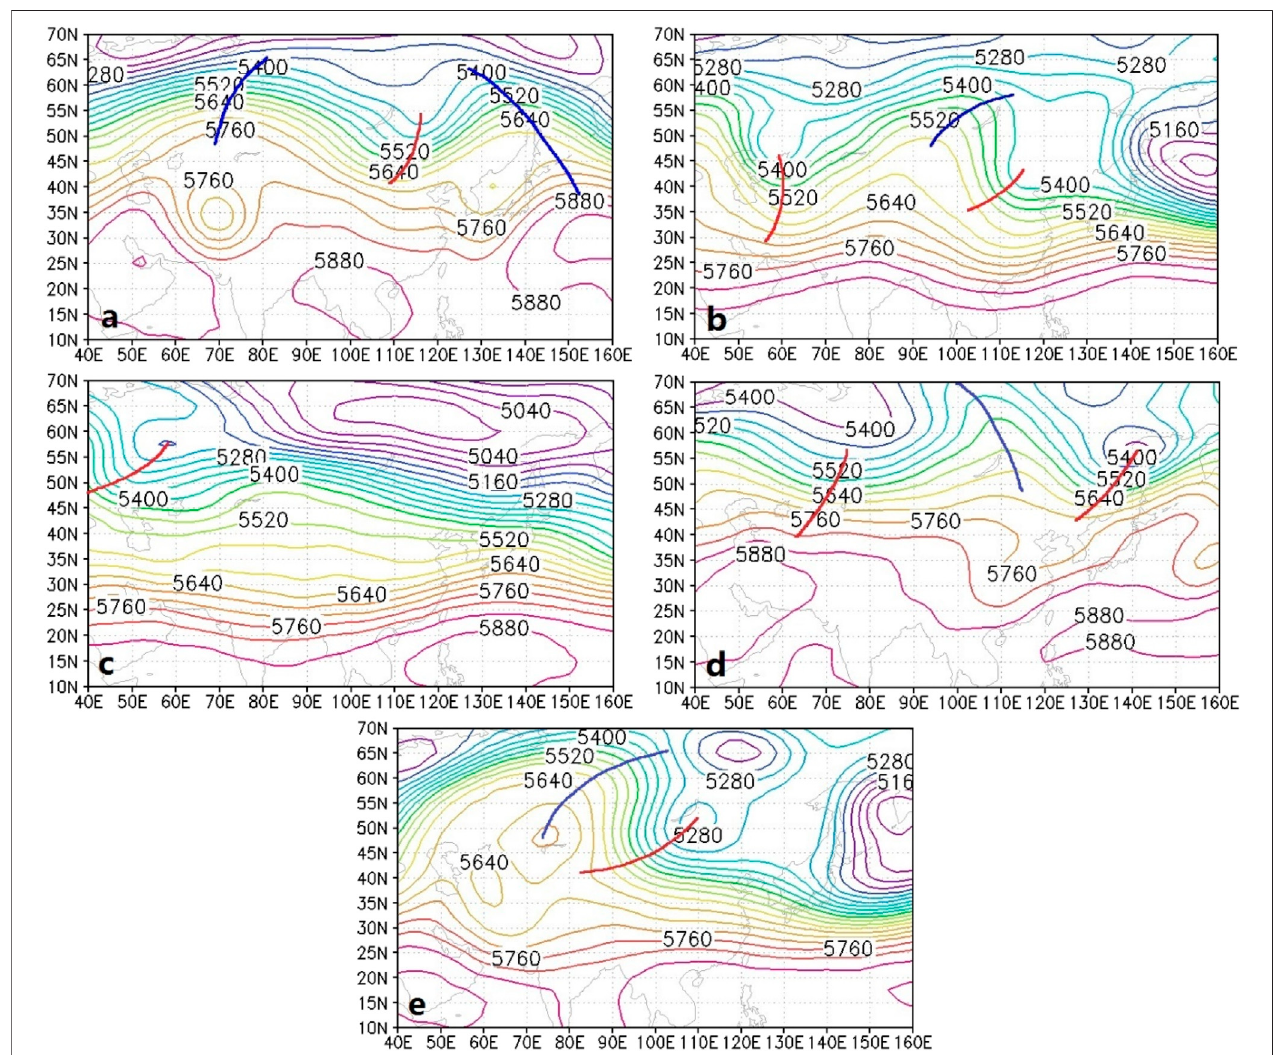
FIGURE 2 | Five 500-hPa circulation patterns favoring hazes in the Jianghuai area, China. They are (A) zonal circulation pattern, (B) two troughs and one ridge pattern, (C) one trough and one ridge pattern, (D) two ridges and one trough pattern, and (E) uniform dynamic geopotential height pattern.